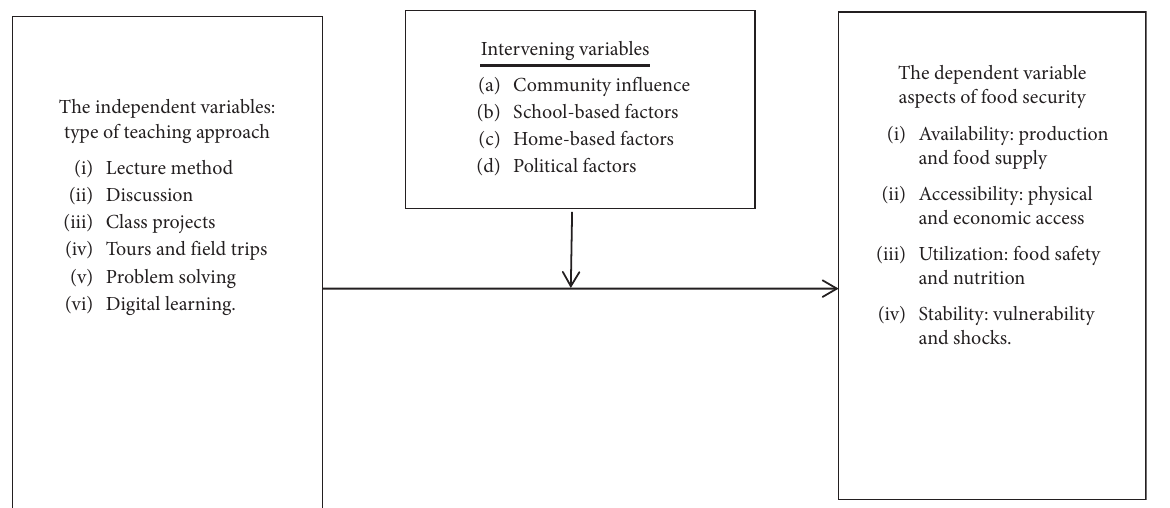
Figure 1: Relationship between the agricultural teaching approaches and aspects of food